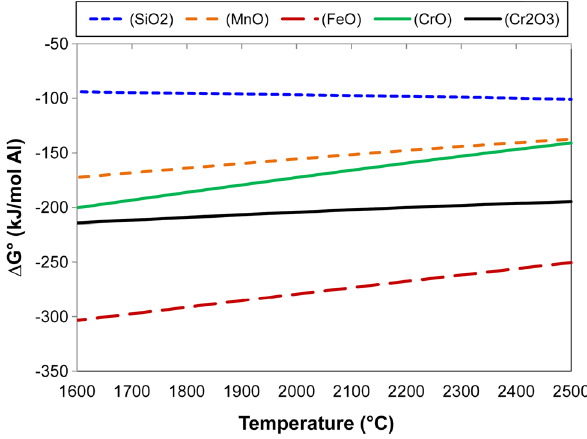
Figure 5: Gibbs free energy plot for reactions ( 2 ) – ( 6